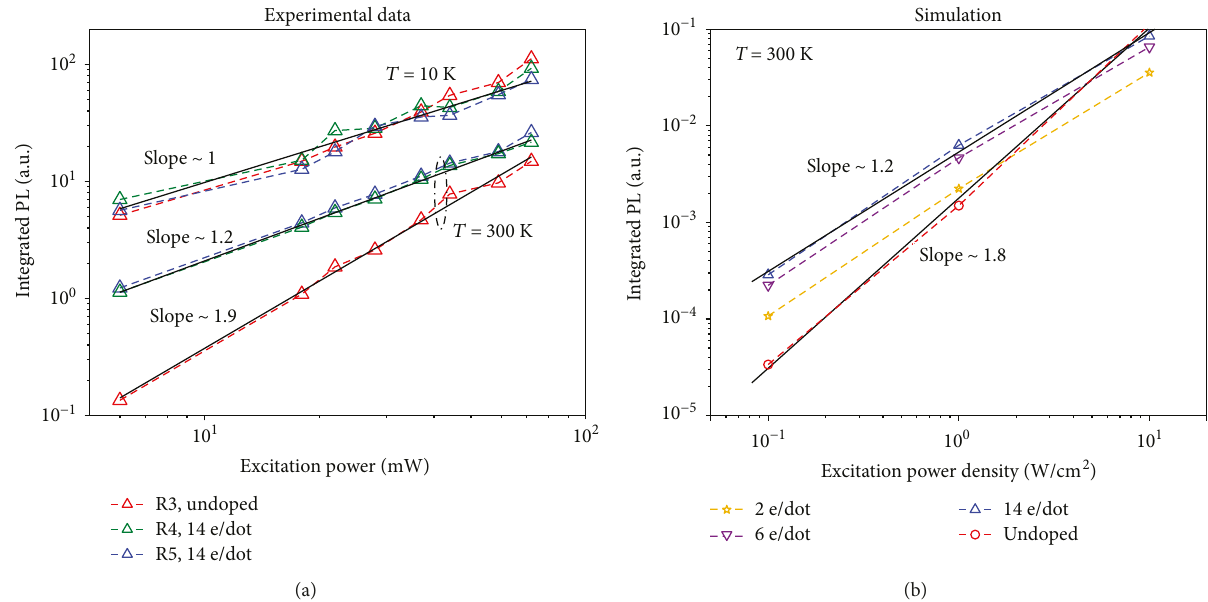
Figure 7: (a) Measured IPL intensity versus excitation power. (b) Simulated IPL intensity versus excitation power density. In the experiments, the equivalent excitation power density was about 1 W/cm 2 at power of 16 mW/cm 2